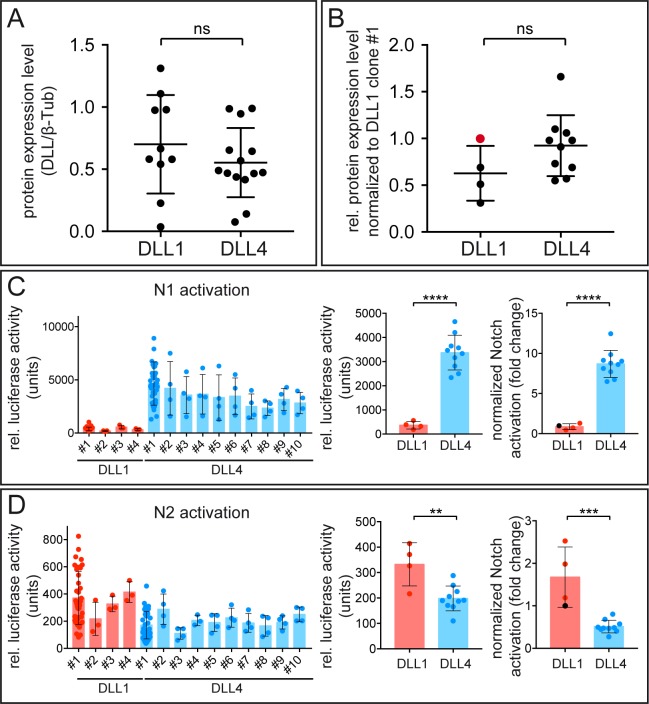
Consistent N1 and N2 activation by different cell clones expressing DLL4.(A) Protein expression level in DLL1 clone #1 and DLL4 clone #1 (DLL ligand/β-Tub) determined by quantitative Western blot analysis. Each dot represents a technical replicate (numerical values in Figure 4—source data 2). (B) Relative protein expression level in 4 and 10 independent ES cell clones, respectively, expressing DLL1 or DLL4 from the Hprt locus normalized to DLL1 clone #1 level measured in the same assay. Each dot represents the mean value of n ≥ 3 independent measurements of a single clone. Red dot indicates DLL1 clone #1 that was used for normalization. For numerical values see Figure 4—figure supplement 1—Source Data 1. (C) and (D) N1 and N2 activation by 4 DLL1 and 10 DLL4 expressing independent ES cell clones. Left graphs show rel. luciferase activity measured for each DLL1 and DLL4 expressing clone. Each dot represents a technical replicate of a given cell clone. Central graphs show averaged rel. luciferase activity for DLL1 and DLL4 expressing cell clones. Each dot represents the mean value of n ≥ 3 measurements of a given cell clone. Right graphs show Notch activation normalized to activation by DLL1 clone #1 (n ≥ 3). Black dots indicate DLL1 clone #1. For numerical values see Figure 4—figure supplement 1—Source Data 2. Student’s unpaired t-test; Mean ±SD, ns = not significant; **=p ≤ 0.01; ***=p ≤ 0.001; ****=p ≤ 0.0001.10.7554/eLife.40045.011Figure 4—figure supplement 1—source Data 1.Numerical values used to generate the graph in Figure 4—figure supplement 1B.DLL1 and DLL4 protein levels in different ES cell clones were determined by quantitative analysis of Western blots and the relative protein expression was obtained by normalization to DLL1 clone #1 analyzed in the same assay. The value obtained in assay 13 (red) represents an outlier (determined by ROUT analysis using GraphPad Prism7) and was not included in the calculation of the average.10.7554/eLife.40045.012Figure 4—figure supplement 1—source Data 2.Numerical values used to generate the graphs in Figure 4—figure supplement 1C,D.N1 and N2 activation by different ES cell clones expressing DLL1 and DLL4.